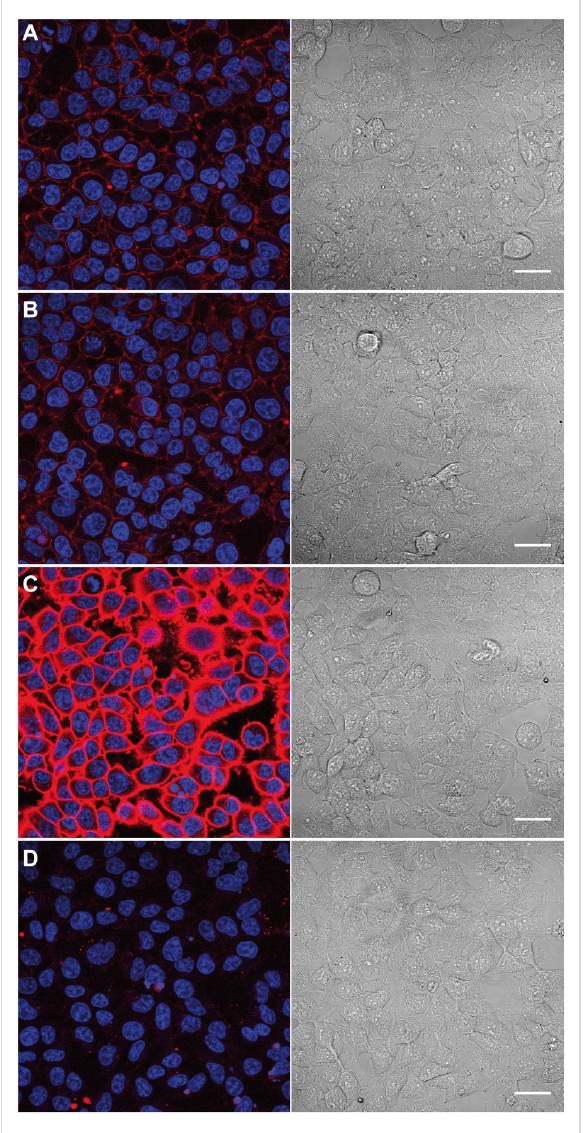
Figure 2: Labeling of metabolically engineered cell-surface glycocon- jugates. HEK 293T cells were grown for 48 h with 50 µM Ac 4 GlcN- Cyoc ( 1 , A), 50 µM Ac 4 GalNCyoc ( 2 , B), 50 µM Ac 4 ManNCyoc ( 3 , C), or with PBS (solvent control, D) and subsequently incubated with Tz–biotin 10 (1 mM, 1 h, 37 °C) followed by incubation with strepta- vidin–AF647. Nuclei were stained with Hoechst33342. Scale bar: 30 µm.